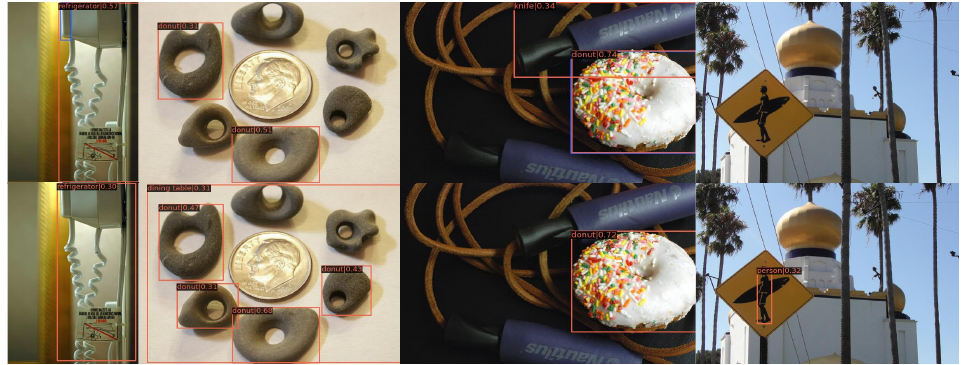
Figure 5. Comparison of the inference output of BFT and FPN. The upper layer is the output of ATSS with FPN, and the lower layer is the output of ATSS with